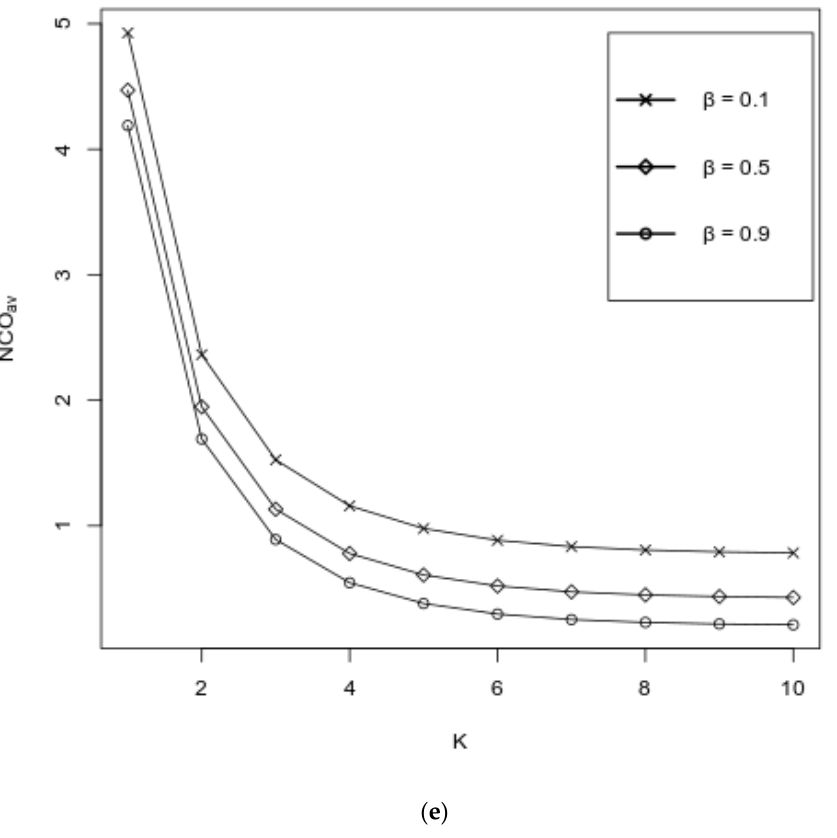
Figure 4. Loss probabilities of p -customers ( a ) and r -customers ( b ), the average number of busy ( c ) and failed servers ( d ) and the average number of r-customers in the orbit ( e ) versus the number of servers under various values of 𝛽 .